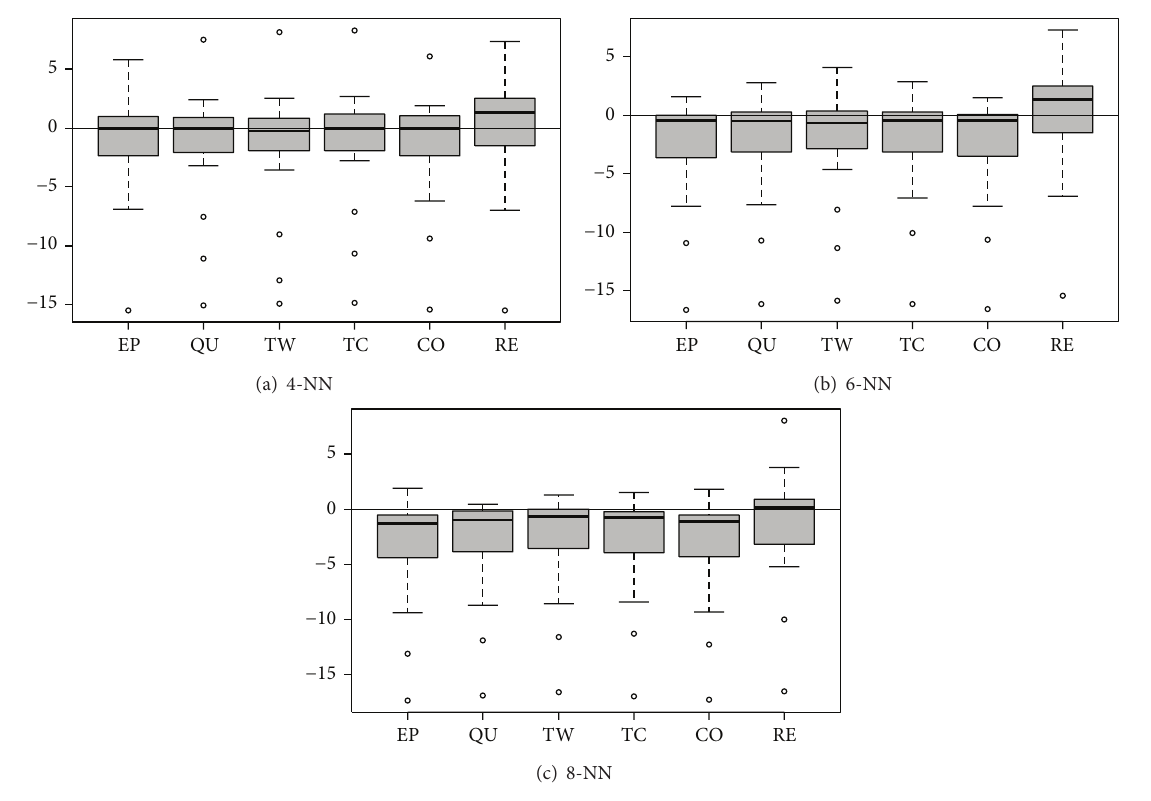
Figure 2: Box plots for difference between actual precipitation and interpolated precipitation. 𝑦 -axis represents mm per day.